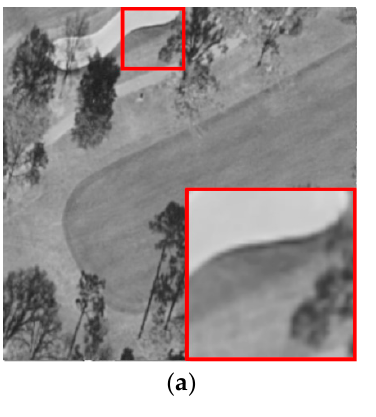
Table 4. Average despeckled results for various experiments on 10 synthetic images.